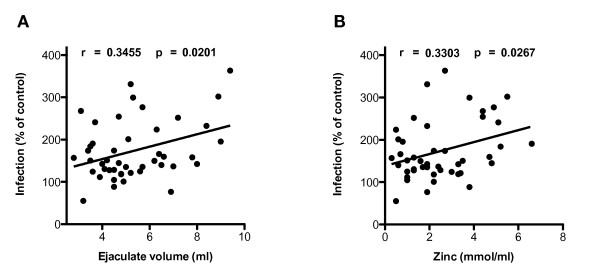
Infectivity enhancing potential of semen samples correlates with clinical semen parameters. Ejaculate volume (A) and zinc concentration (B) were plotted against the enhancement of HIV-1 infectivity. Correlations were determined using the two-tailed Pearson correlation coefficient.